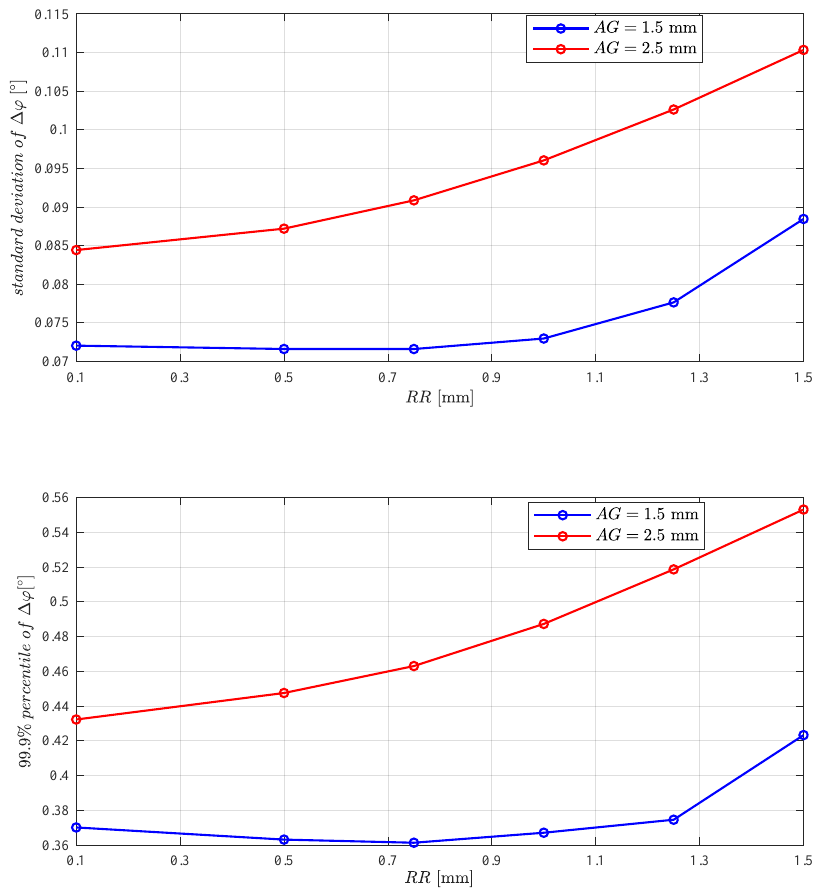
Figure 4. ( a ) Standard deviation and ( b ) 99.9% percentile of ∆ ϕ (at ϕ = 33.75 ◦ ) over reading radius RR for two air gaps AG . Data are from Figure 3. The ratio of percentile versus standard deviation is ≈ 5.03 and it varies about ± 3.5% versus both AG